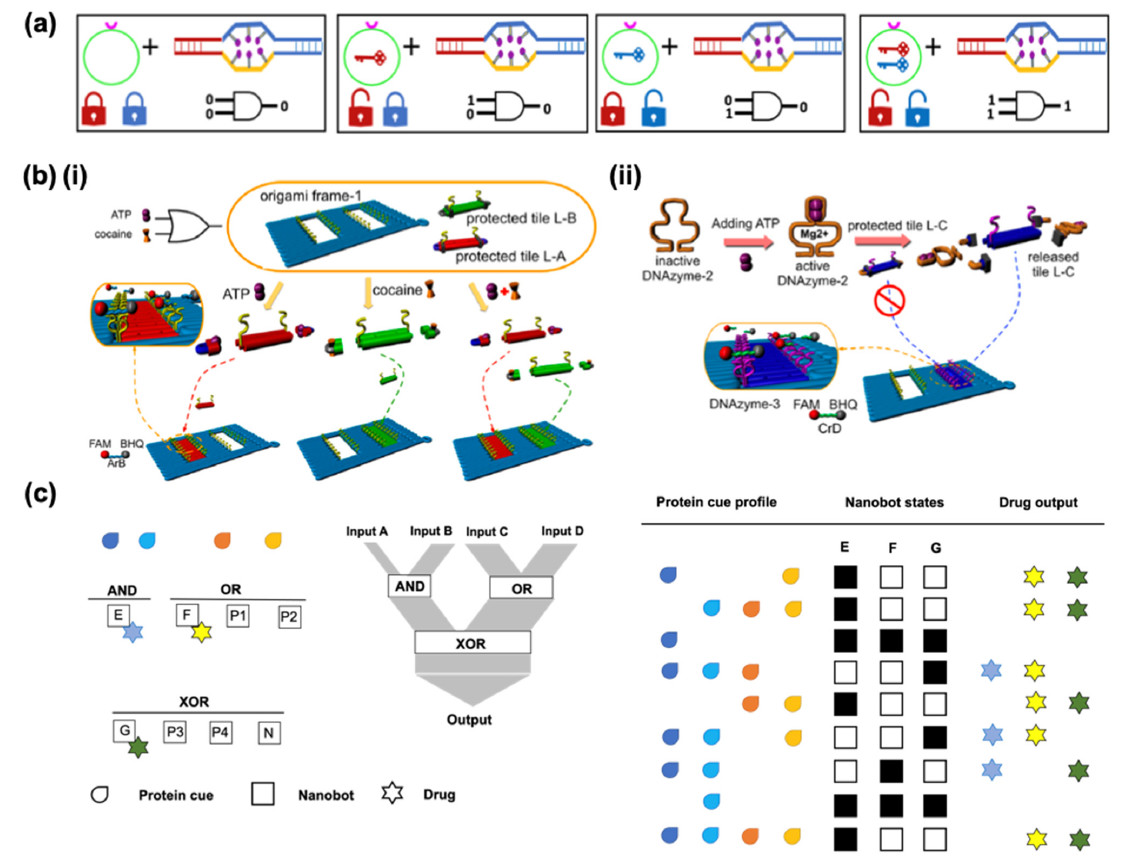
Figure 7. Logic-gated nanorobots; inputs (A, B), outputs (1,2). ( a ) Nanorobot activation via an AND logic gate. The aptamer-encoded locks respond to molecular input (key)-expressing cells leading to the conformational change of the nanorobot as an output. Redrawn from [109]. ( b ) Aptamer-binding directed DNA origami pattern for logic gates: ( i ) operation of an OR logic gate through a DNA origami using ATP and cocaine as two independent inputs to trigger the filling patterns, and ( ii ) operation of a two-layer YES gate where an active DNAzyme is designed to leave the protected tile to prevent direct filling into the origami. Adapted with permission from [114]. Copyright © 2022, American Chemical Society. ( c ) A hypothetical system consisting of eight robot types capable of simultaneously controlling three therapeutic molecules: three effector robots E, F, and G, each carrying a different drug; four positive regulators, P1 and P2 keying F, and P3 and P4 keying G; and a negative regulator N inactivating G forming two first-layer gates, AND and OR, each controlling a respective drug while relaying its outputs to a second-layer XOR gate that controls the third drug. Redrawn from [113].